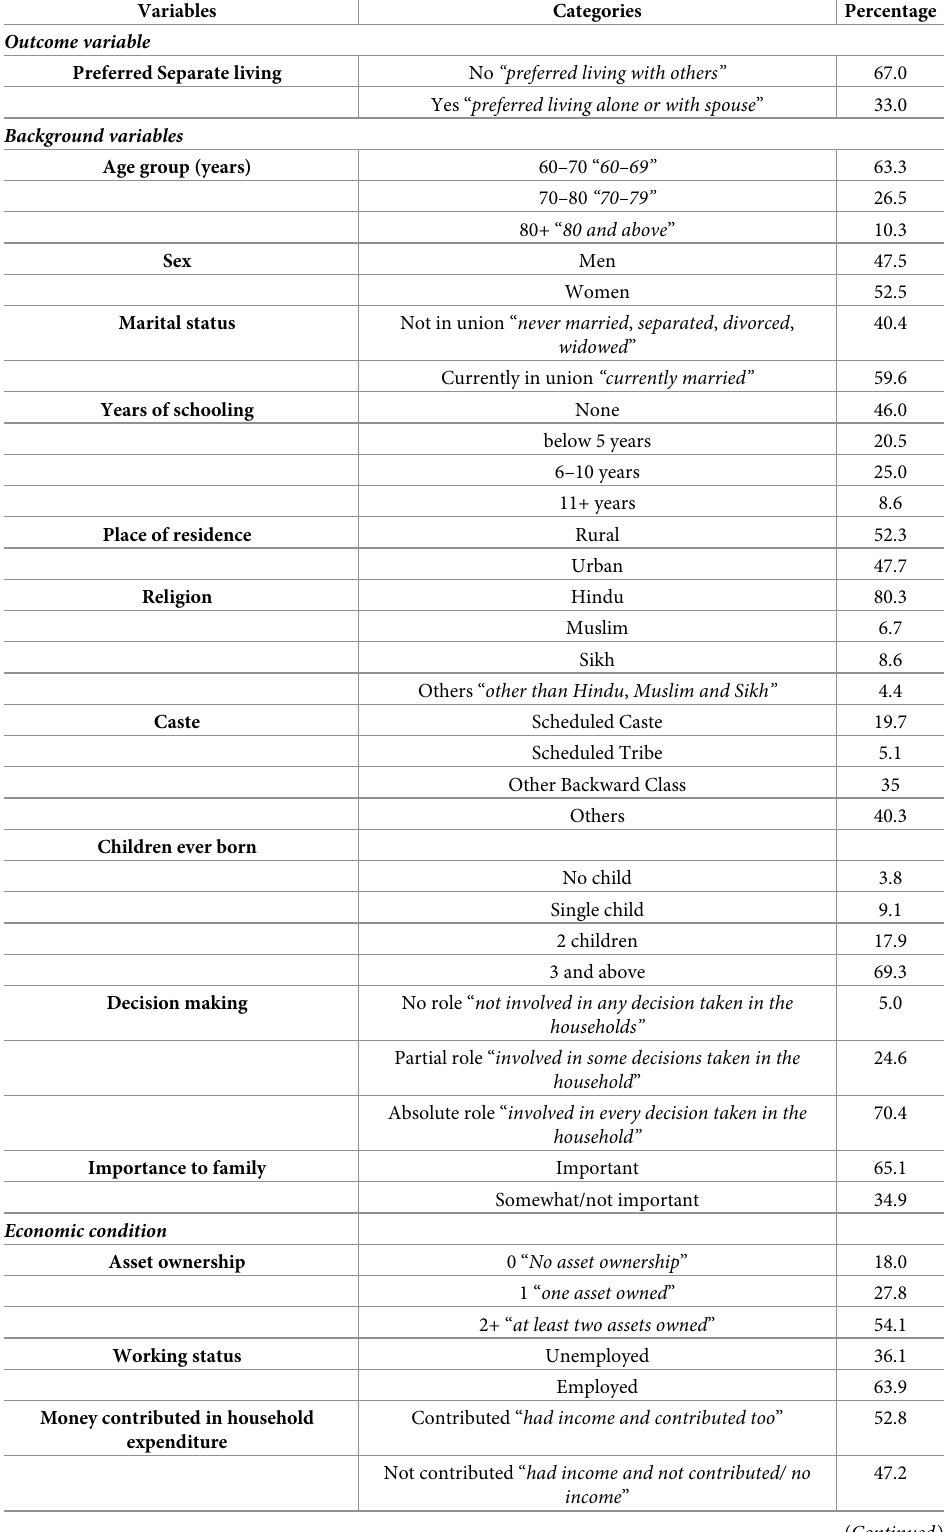
Table 1. Socio-economic profile of older adults in India. (N =